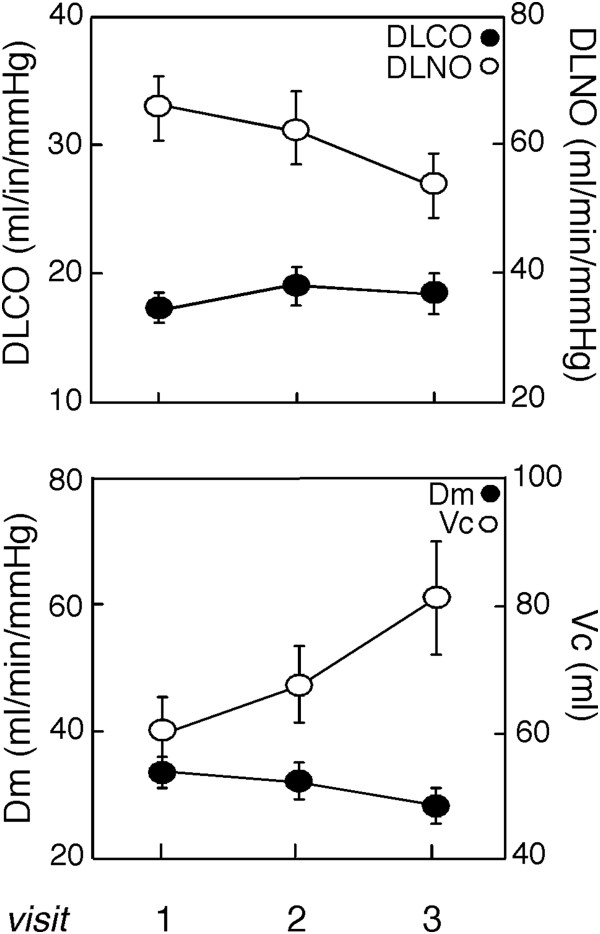
Lung diffusion capacity and its components over time in pulmonary arterial hypertension. Lung diffusing capacity for NO (DLNO) and the alveolar-capillary membrane diffusing capacity (Dm) decreases over time (both p = 0.01). Lung capillary blood volume (Vc) tends to increase over time (p = 0.07). Conversely, DLCO did not change significantly (p = 0.7).